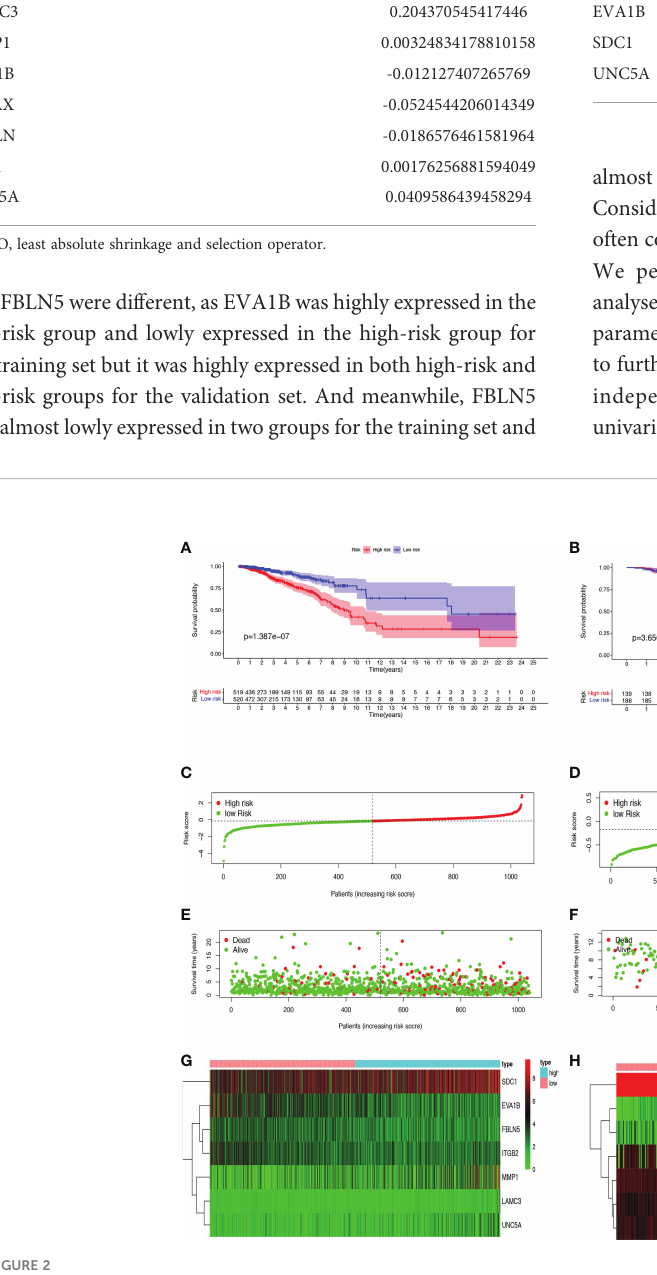
FIGURE 2 Prognosis and risk score analysis of the 7 BMRGs. (A, B) Survival analysis based on the Kaplan-Meier method for OS of BC patients in high- and low-risk groups and plotting survival curves. (C, D) Risk score distribution of BC patients. (E, F) Scatter plot of BC patients ’ survival status. (G, H) Risk heat map of 7 BMRGs expressions in the training set (G) and validation set (H) . (A, C, E) Training set (TCGA cohort); (B, D, F) Validation set (GEO cohort); BC, breast cancer; OS, overall